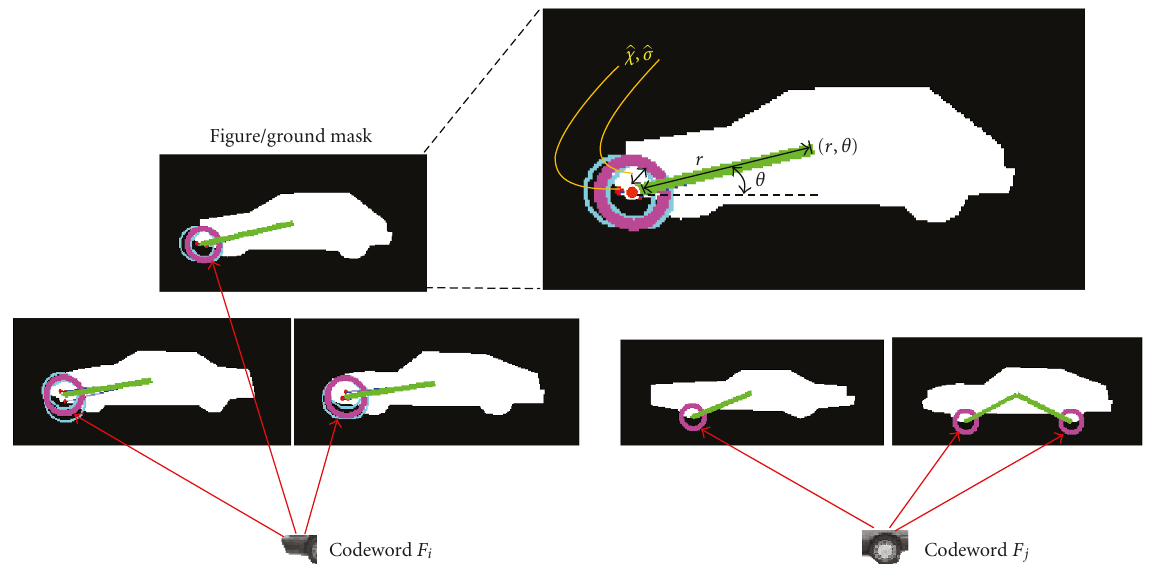
Figure 18: Learning CCB pose including figure-ground mask.